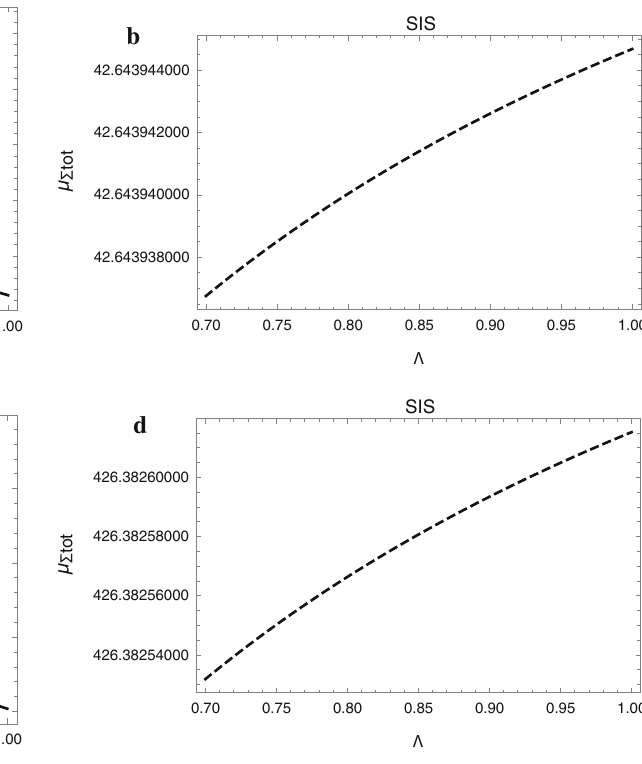
vs. Λ when β = 0 . 0001 for the SIS distribution. In all the figures we considered D ls = 10, D l = 100, D s = 110, ω 2 e /ω 2 = ω 2 c /ω 2 = 0 . 5, = 0 . 001818, and ˜ J = 0 . θ E r